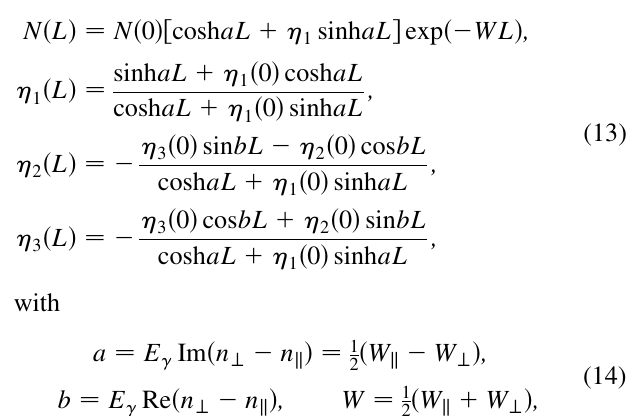
2 : 3 mrad with respect to the h 110 i axis and lies in the (110) plane ( beam traverses the (110) plane at a small